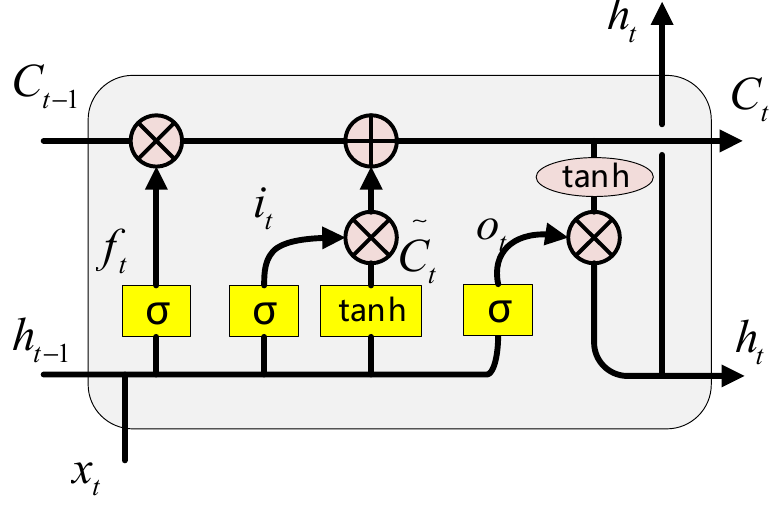
Figure 5. An LSTM unit structure.